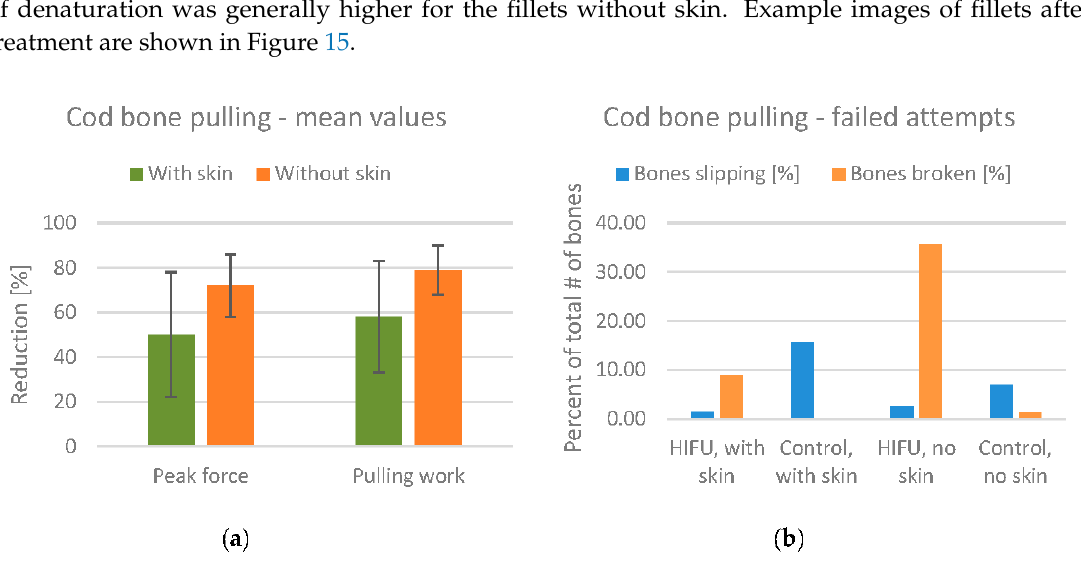
Figure 14. ( a ) Mean values for the reduction of bone pulling force and work in cod fillets, with error bars marking corresponding mean standard deviation values. Reduction percentages are calculated relative to the control fillet from the same fish; ( b ) Number of failed bone pulling attempts in cod fillet experiments.